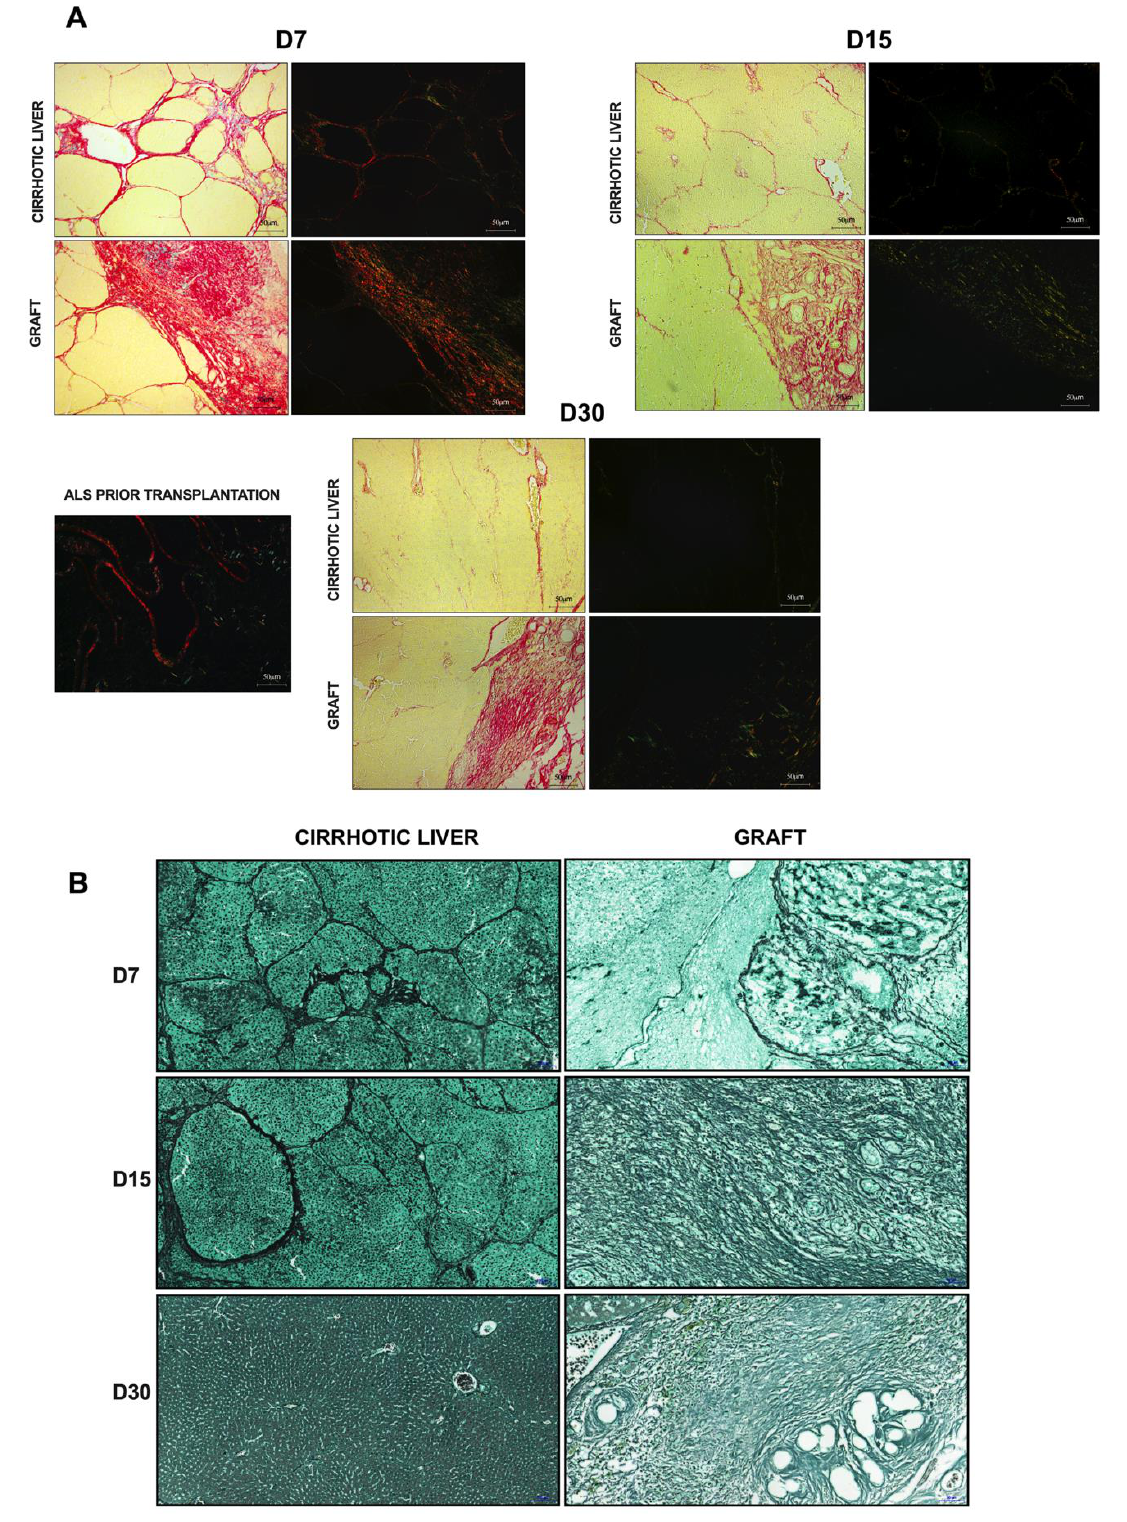
Figure 12. Acellular liver scaffold recellularization contributes to ECM production and remodel- ing after transplantation in cirrhotic rats. Sirius red staining under bright (left) and polarized light (right) shows collagen I and III distribution in ALS prior to transplantation, in the graft and cirrhotic liver at 7, 15, and 30 days post-transplantation ( A ). Reticulin staining revealed reticular fibers in the graft and cirrhotic liver at 7, 15, and 30 days post-transplantation ( B ) . Scale bars: 50 μm. 3.10. Acellular Liver Scaffold Transplantation Attenuates Liver Cirrhosis